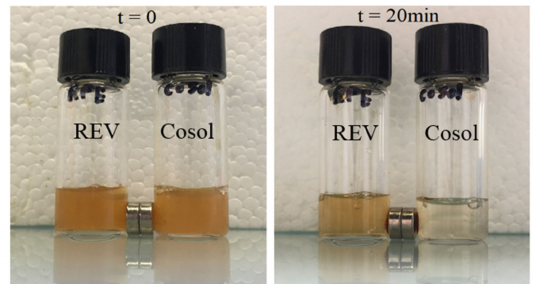
Figure 13. Attraction of MCL formulations when exposed to a magnet. REV_MCLs and cosol_MCLs were put in 2 vials at a concentration of 5 mM of Fe. Two small NdFeB magnets (0.34 T) were placed next to the vials for 20 min. REV:MCLs by reverse phase evaporation method; cosol: MCLs by the cosolvent sonication method.